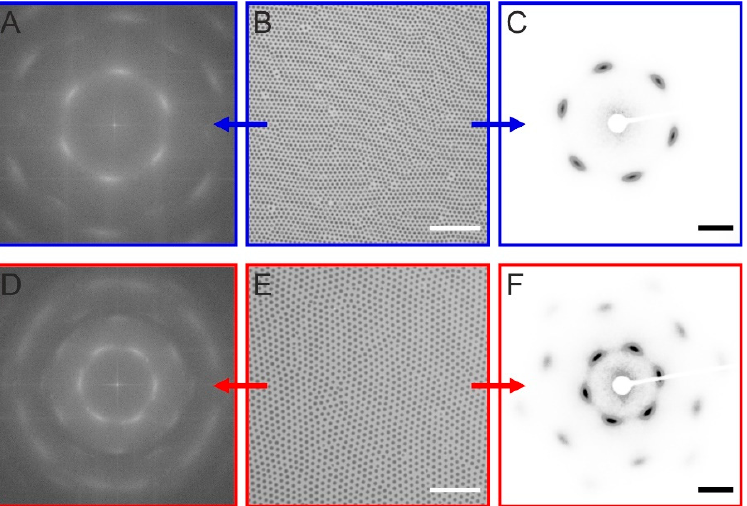
Figure 3. Monolayer analysis by optical light microscopy and SALS. ( A ) FFT generated from the real space microscopy image of a monolayer prepared from C 245 S 2.9 taken at a surface pressure of 20 mN/m ( B ). ( C ) Corresponding diffraction pattern recorded by SALS. ( D , E ) same set of data as in the top row for a monolayer prepared from C 455 S 2.3 . Scale bars in ( B , E ) correspond to 10 µ m. Scale bars in ( C , F ) correspond to 20